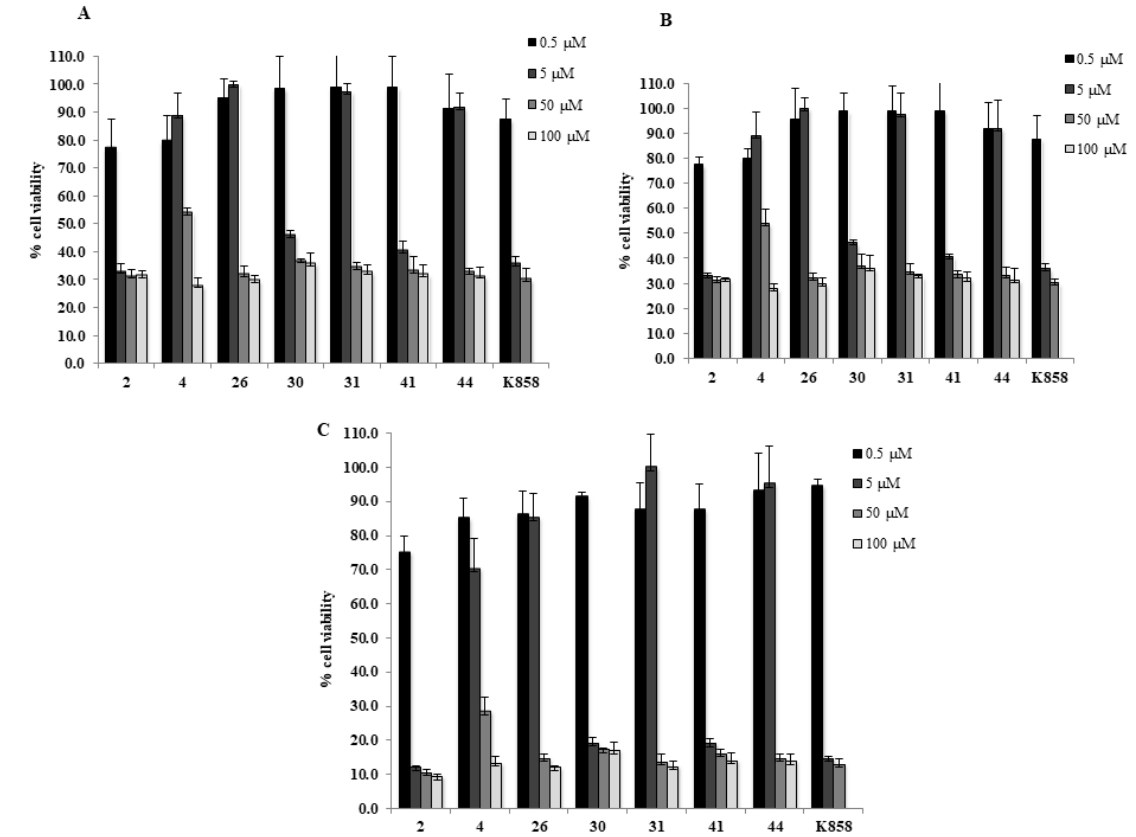
Figure 2. MTT cell viability assay on AGS. Histograms represent the viability dose-response of AGS cells exposed to different concentrations of compounds 2 , 4 , 26 , 30 , 31 , 41 , 44 , and K858 (from 0.5 to 100 μM) for 24, 48, and 72 h ( A – C , respectively). Metabolic activity was assessed using MTT assay and normalized to control cells treated with DMSO (0.2% as final concentration).